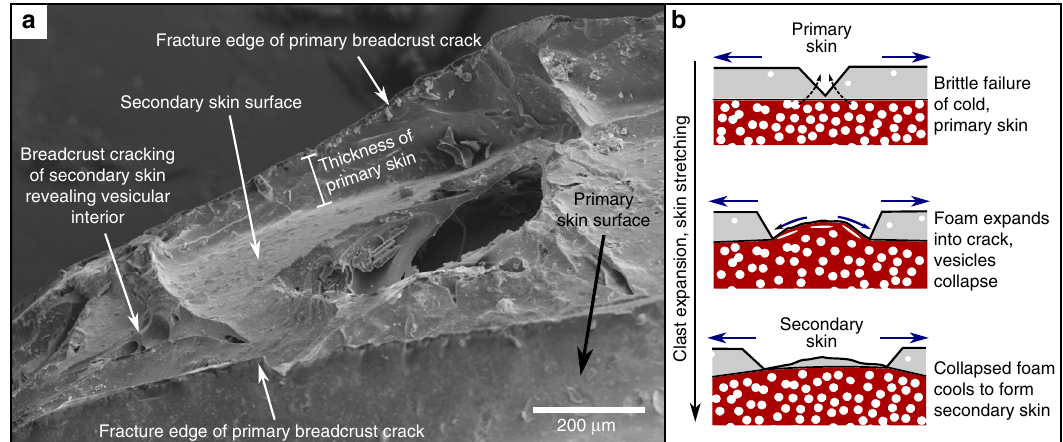
Fig. 4 The healing process of breadcrust textures in pumiceous achneltihs. a Annotated oblique SEM image of a breadcrust scar on an FQA. b Conceptual model showing the formation of breadcrust scars, a feature developed during the transition between brittle and ductile skin regimes in the growth of pumiceous achneliths. This process enhances cooling of the internal foam, and keeps the surface temperature higher allowing extended ductile behaviour by